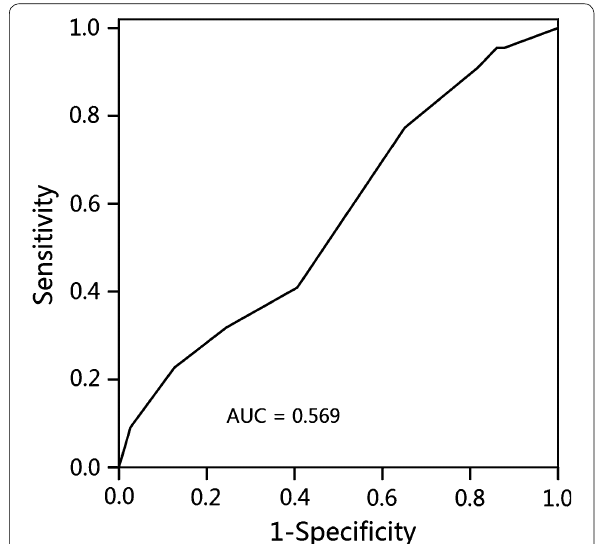
Fig. 1 Receiver operating characteristic curve analysis of the short diameter of the largest enlarged neck lymph node (ENLN) in patients with N0‑category nasopharyngeal carcinoma (NPC) for the prediction of disease‑free survival. AUC area under the